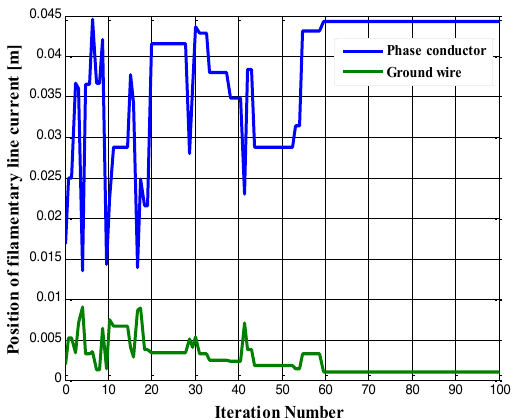
Figure 8: Convergence of the optimum value of position of filamentary current.